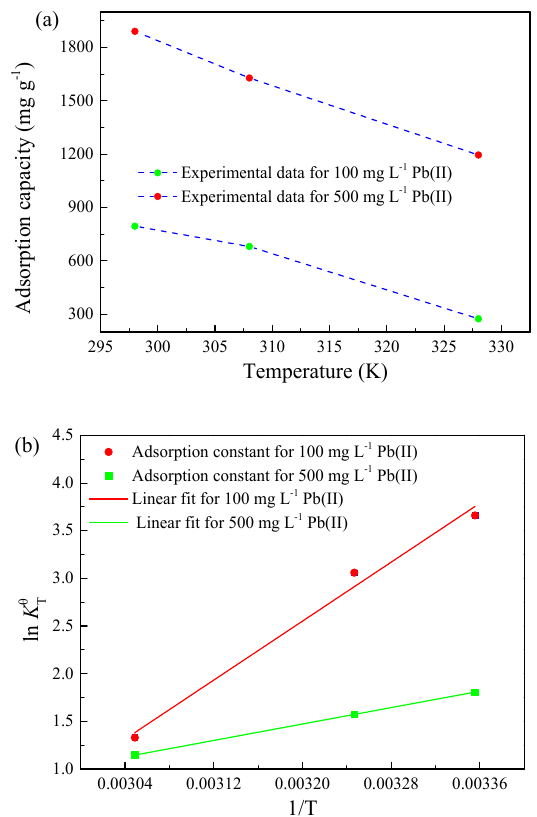
Figure 8. Effect of temperature on the equilibrium adsorption of Pb(II) ( a ) adsorption capacity and ( b ) adsorption constant.